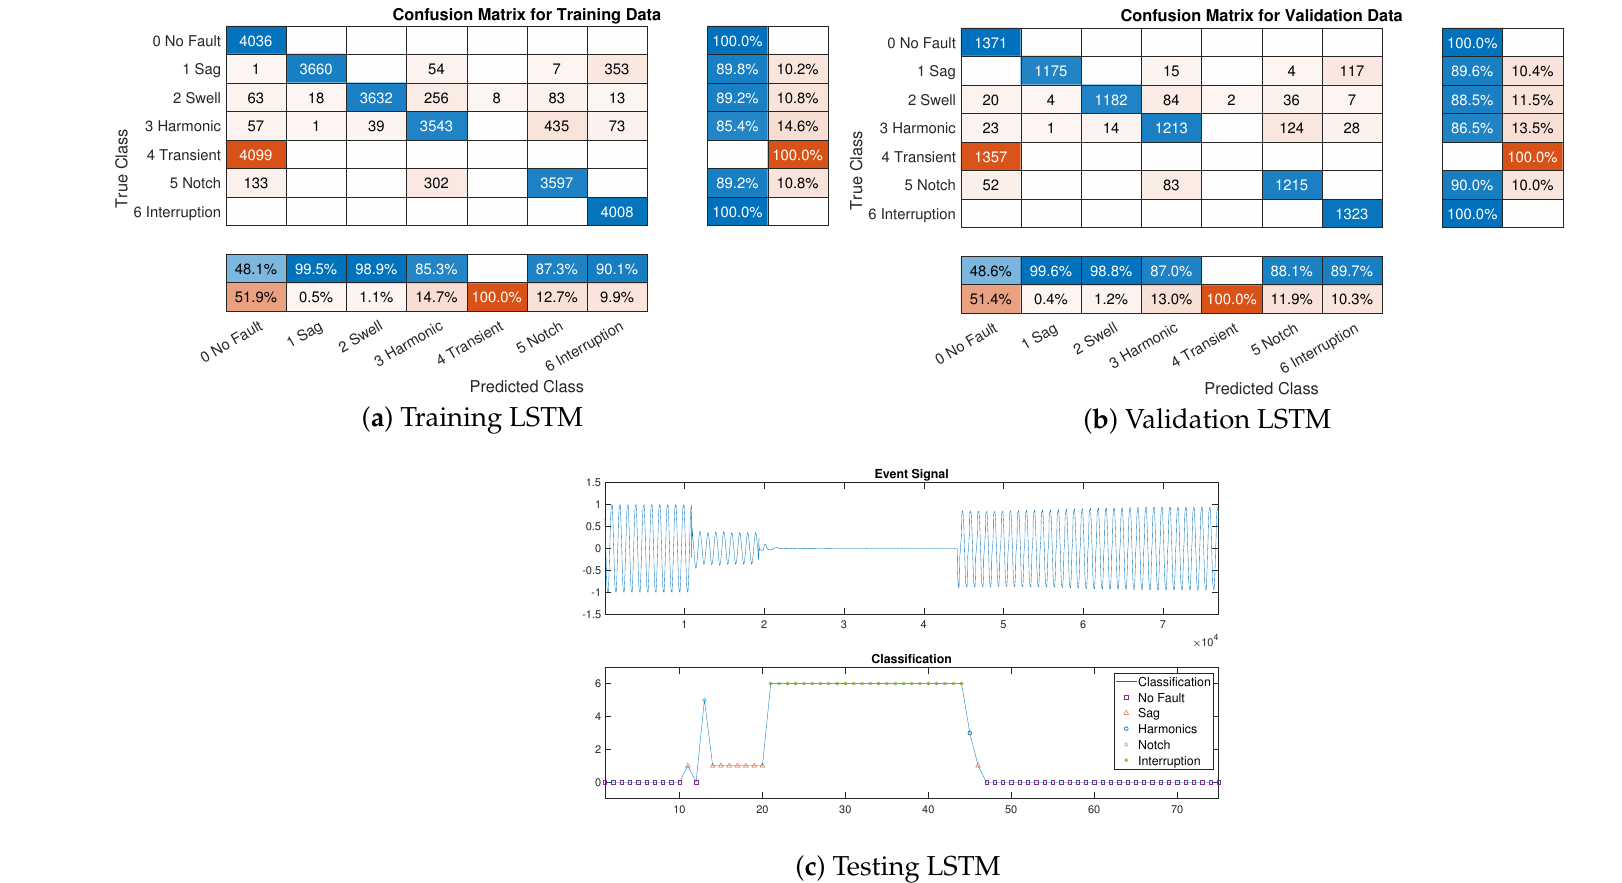
Figure 9. ( a ) Confusion matrix of the LSTM training, ( b ) Confusion matrix of the LSTM validation, ( c ) Testing of the LSTM using a simulated voltage waveform.